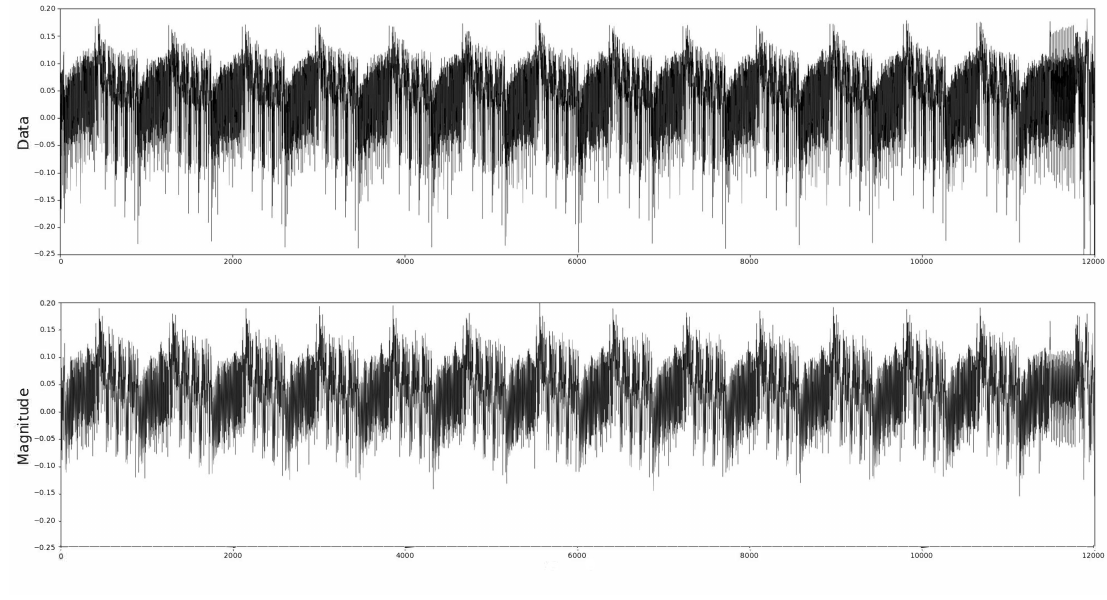
Figure 2. Power consumption traces ( top ) with noise and ( bottom ) without